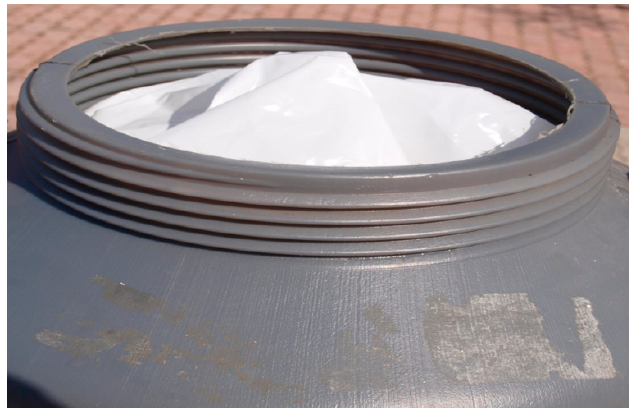
Figure A2. Unmodified industrial barrel (control) with microbial films in the headspace. Figure A1. Different types of industrial plastic barrels used in the black table olive processing. Figure A3. Unmodified industrial barrel (control) with microbial films in the headspace.